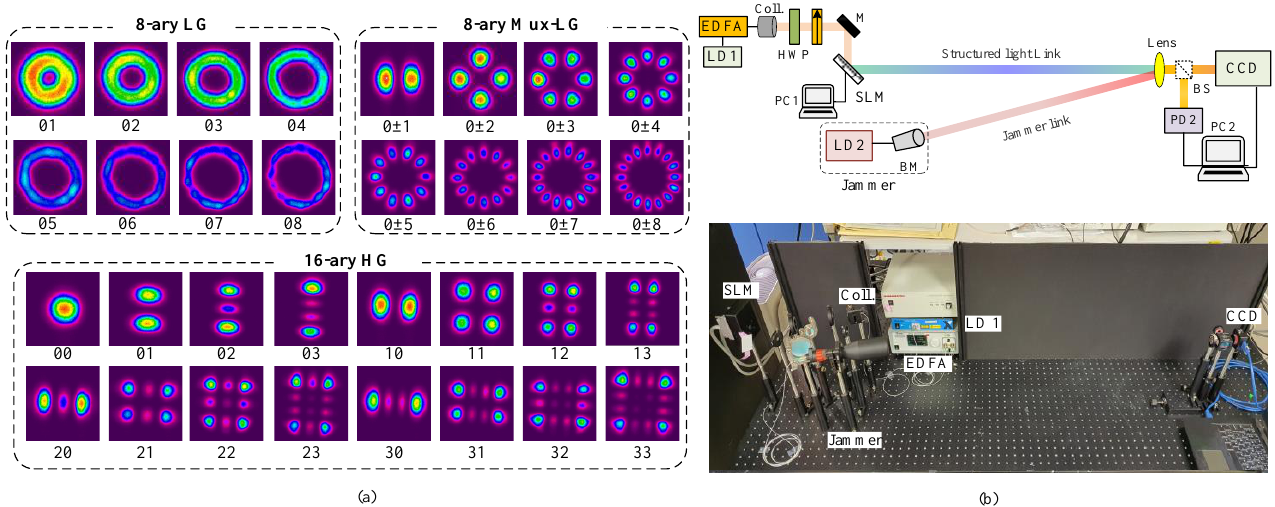
Figure 2. ( a ) Laboratory-generated transverse intensity profiles of LG, superposition-LG and HG modes, ( b ) Experimental setup of M-ary structure pattern transmission with Gaussian jammer. LD: Laser diode; Coll.: Collimator; HWP: Half-wave plate; M: Mirror; SLM: Spatial light modulator; BM: Beam magnifier; PC: Computer; BS: Beam splitter; PD: Photodiode; CCD: Charge-coupled device. Inset is a photograph of the laboratory